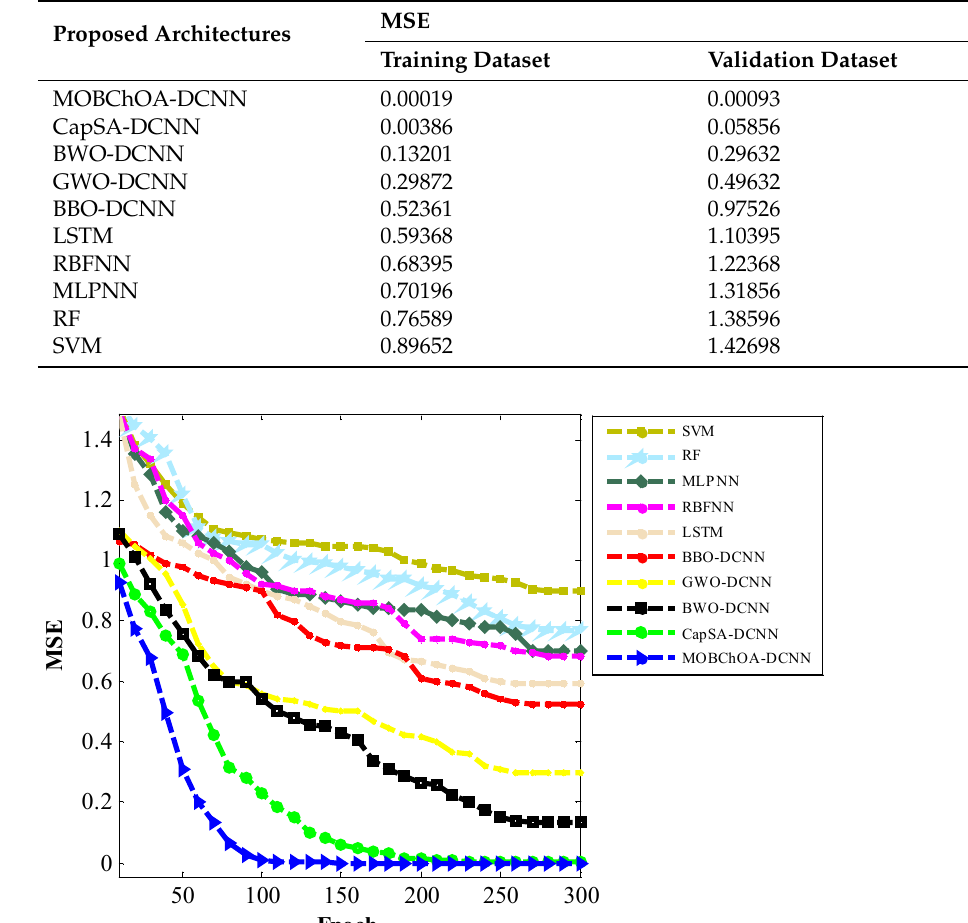
Figure 16. The convergence curves of the architectures for the MSE criterion.